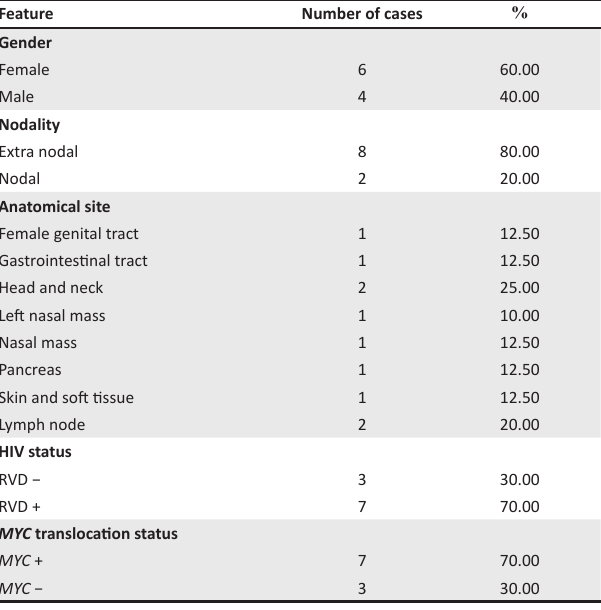
TABLE 1: Summary of the demographic and clinical characteristics of the study cohort. Feature